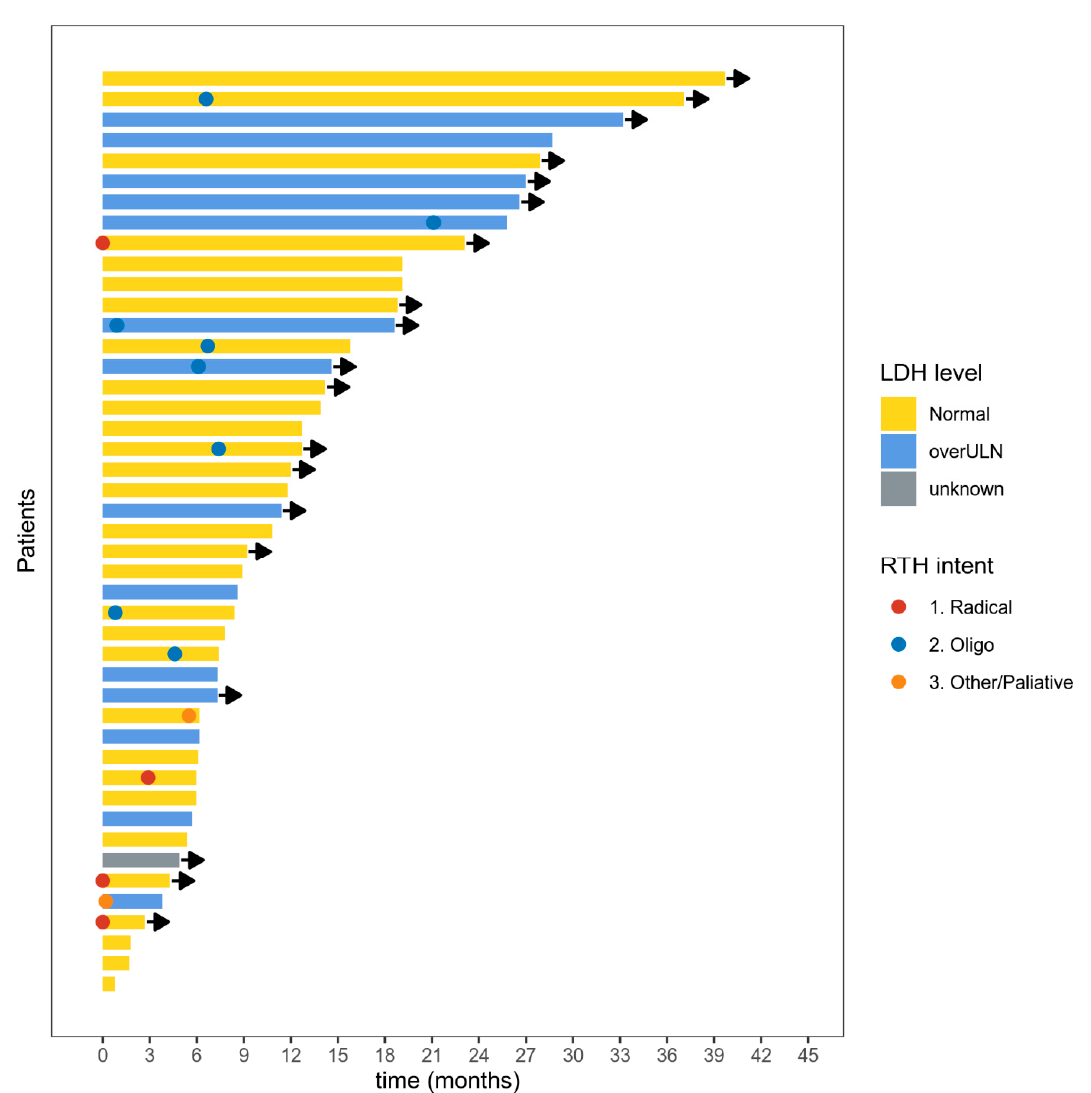
Figure 1. Swimmer plot for the duration of response to the anti-PD1 immunotherapy. Each bar represents a case; arrows represent an ongoing response. LDH level = lactic dehydrogenase activity at the start of treatment. overULN = over upper limit normal. RTH intent = intention of radiotherapy. Oligo = radiotherapy due to oligometastatic / oligoprogressive disease. Radiotherapy after progressive disease according to Response Evaluation Criteria in Solid Tumours (RECIST) 1.1 is not shown. Table 2. Univariable Cox models for overall and progression-free survival. The 95% confidence intervals and p values are listed in brackets.